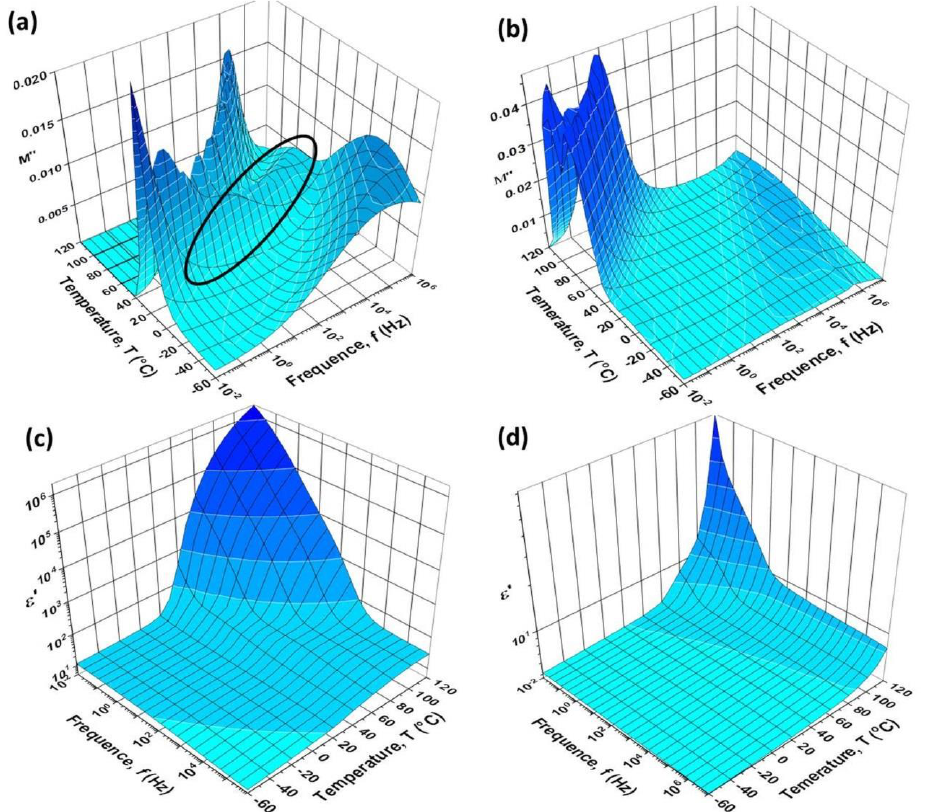
Figure 2. Dielectric spectra of CEPVA ( a,c ), with the relaxation band of the cyanoethyl side groups marked with the black circle, and PVP ( b,d ). Imaginary part of the loss modulus ( a,b ) and real part of permittivity ( c,d ). Measured in N 2 atmosphere.